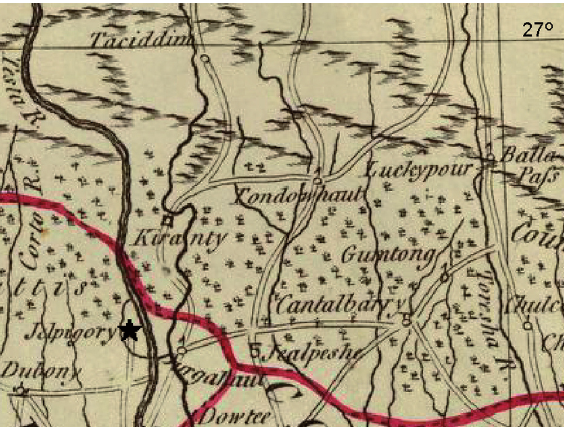
Fig. 3. A part of James Rennell’s map to show forested piedmont between Tista and Kaljani (Rennell 1794). Star indicates Jalpaiguri. Thick red line determined southern border of Dooars before the incorporation into the posses- sions of the British East India Company in